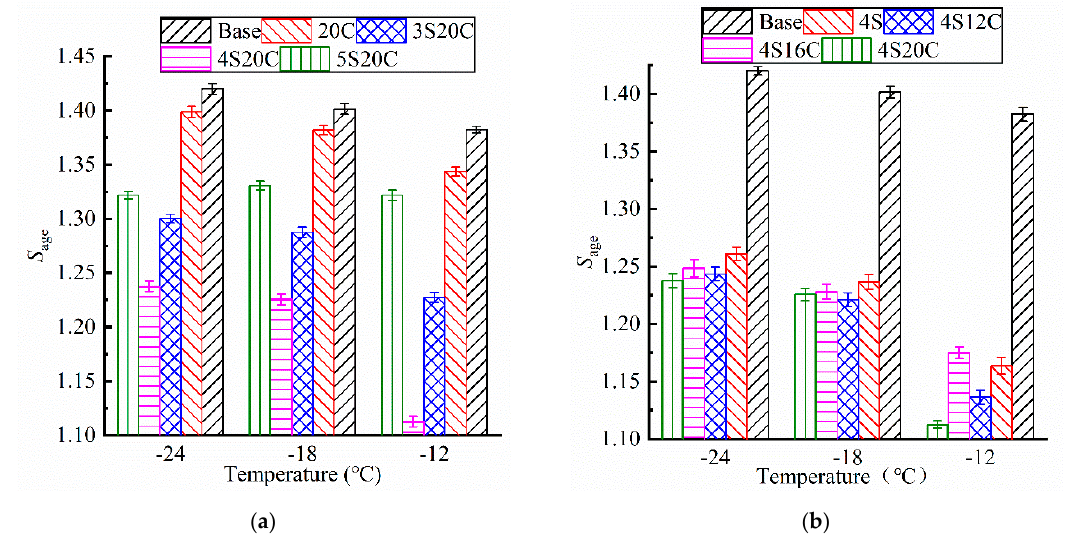
Figure 9. Stiffness modulus aging index ( S age ) of asphalt with different modifier content: ( a ) with Figure 9. Sti ff ness modulus aging index ( S age ) of asphalt with di ff erent modifier content: ( a ) with different nano-SiO 2 , ( b ) with different rubber. di ff erent nano-SiO 2 , ( b ) with di ff erent